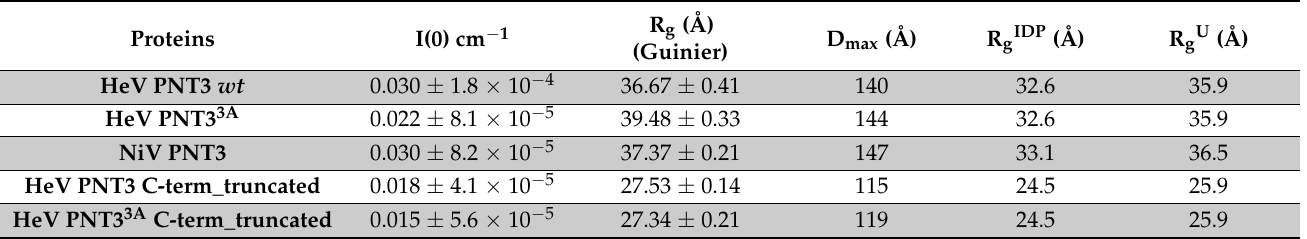
Table 2. R g and D max as obtained from SEC-SAXS studies and expected values for the various conformational